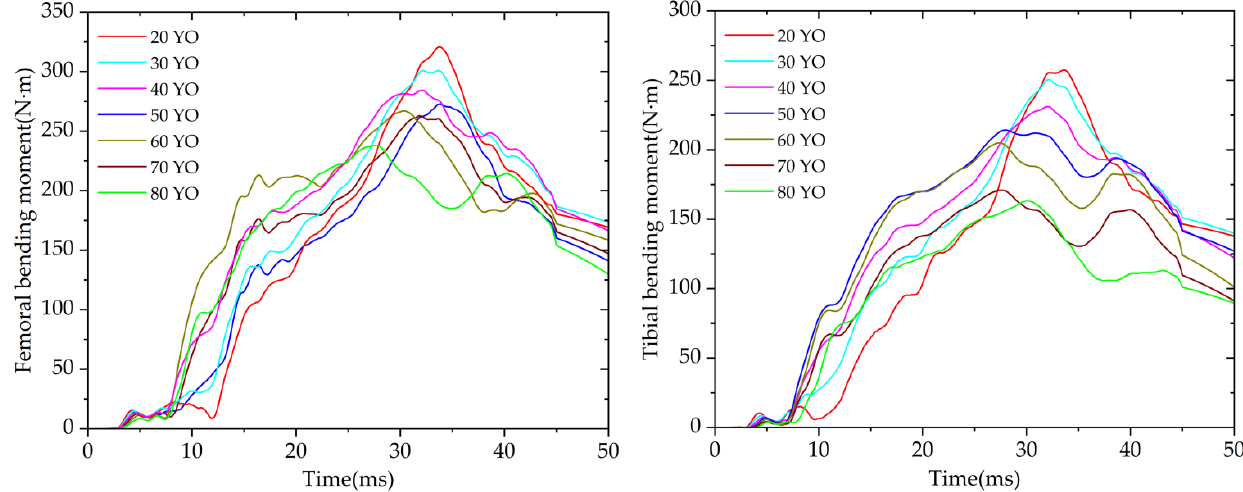
Figure A3. Bending moment of femur and tibia of pedestrians of seven ages at 50 km/h.